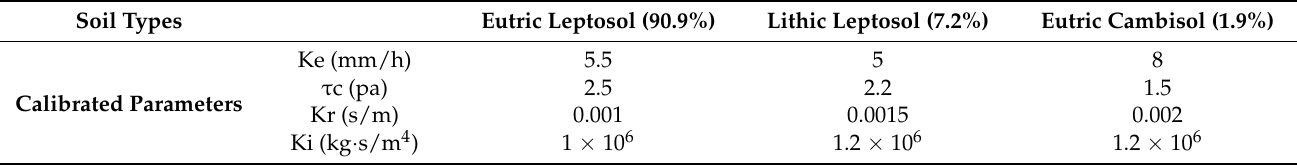
Table 3. Calibrated soil parameters.